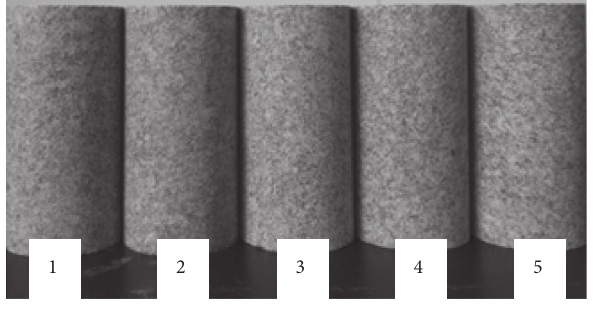
Figure 3: Granite samples.